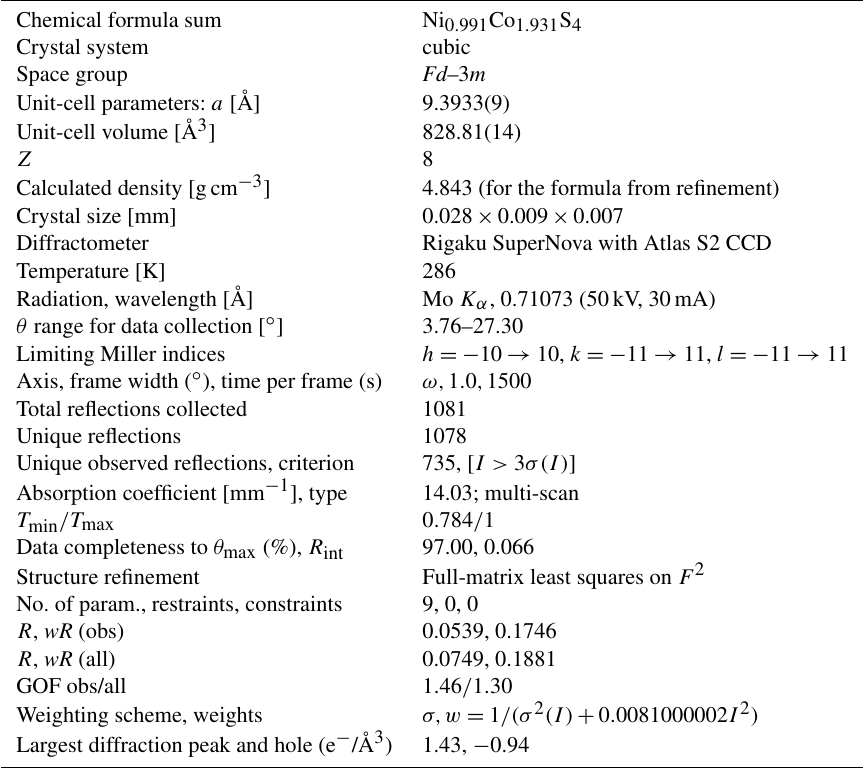
Table 5. Summary of data collection conditions and refinement parameters for grimmite.